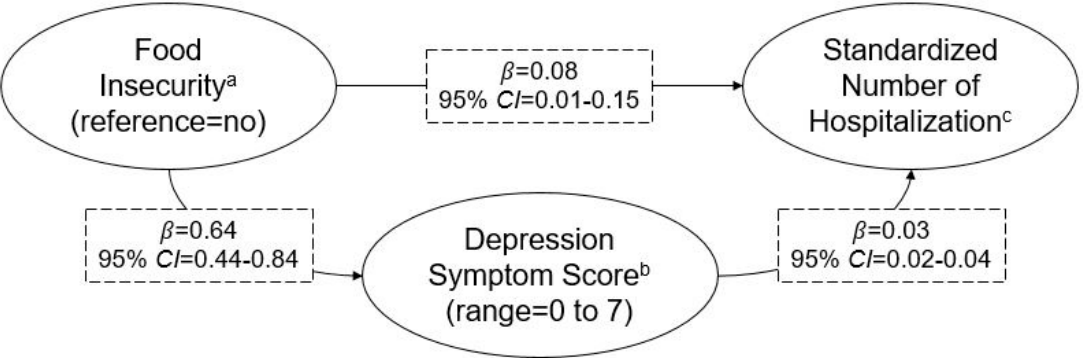
Figure 2. Mediation of the concurrent association between food insecurity and hospitalization frequency by depression symptomology among older adults. Depression symptomology explained 17.4% (95% confidence interval (CI) = 2.8–32.0%) of the concurrent association between food insecurity and hospitalization frequency. Data come from waves 2012 and 2014 of the Health and Retirement Study and limited to those who were not hospitalized in 2012. β ’s represent direct e ff ects and adjust for gender, age group, race / ethnicity, marital status, educational attainment, work status and household income-to-poverty ratio. a Collected in 2014 and assessed over the prior 24 months; those who reported that they could not always a ff ord food due to lack of financial resources or ate less than desired were